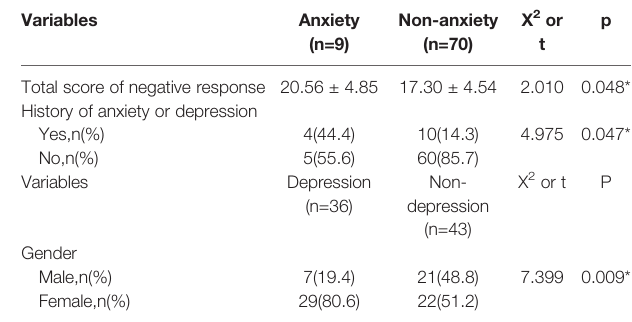
TABLE 3 | Possible in fl uencing factor related to anxiety or depression in